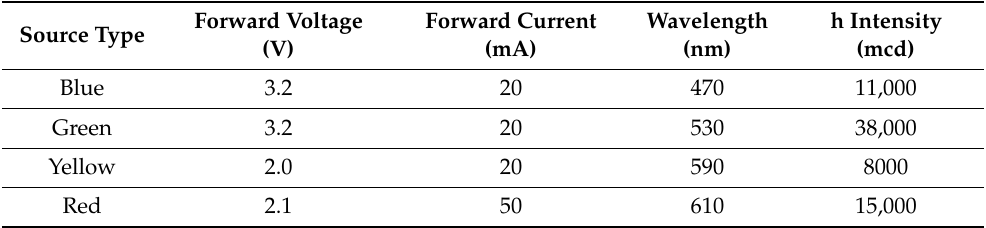
Table 1. Characteristics of the light sources used to characterize solar cells coated with different zeolite layers. Source